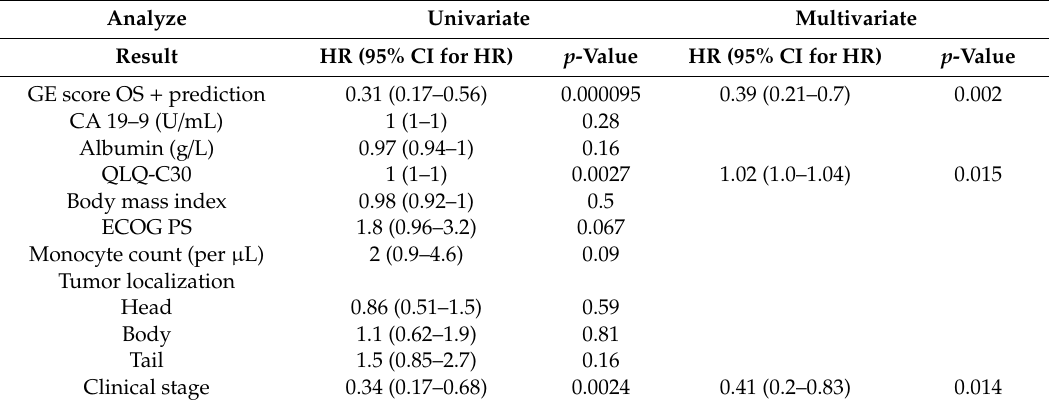
Table 1. Multiple regression analysis of overall survival factors by multivariable